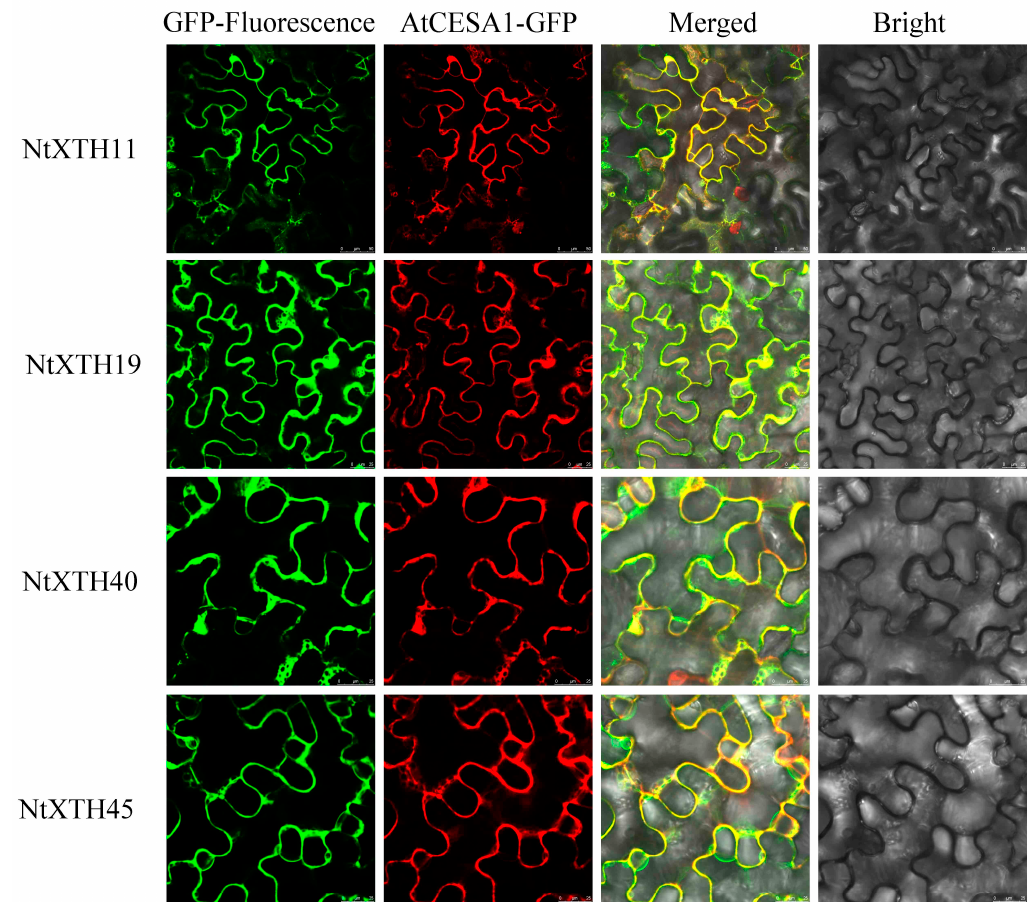
Figure 6. Subcellular localization of NtXTHs proteins. Transient expression of 35S :: NtXTHs-GFP and 35S :: AtCESA1-RFP in tobacco epidermal cells. AtCESA1-RFP is a plasma membrane marker protein. The green fluorescent signals of NtXTHs-GFP can be merged with the red fluorescent signals of the plasma membrane marker.